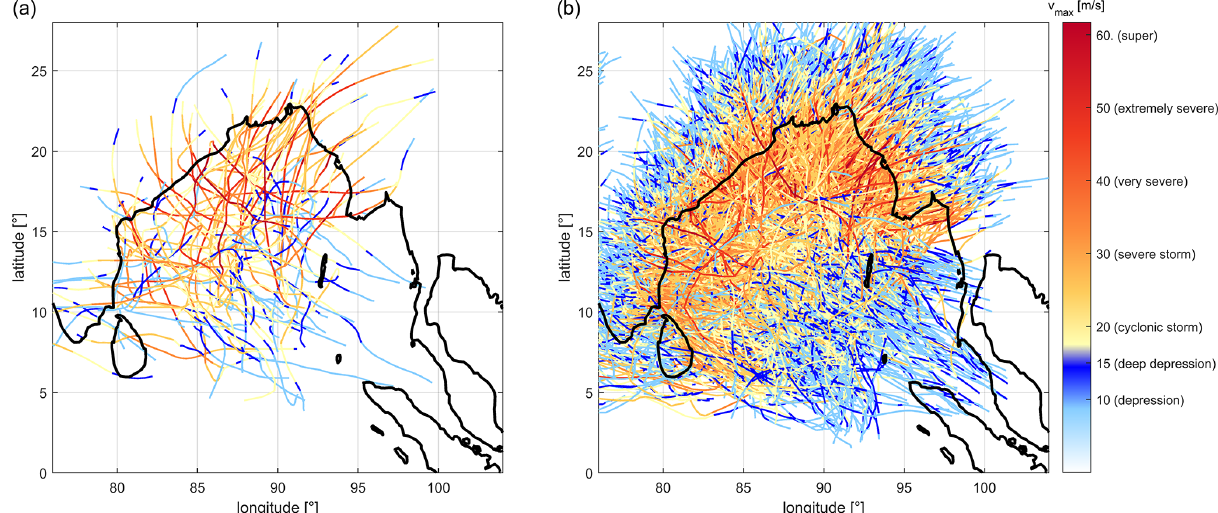
Figure 2. Cyclone tracks subdivided into different cyclone wind speed categories based on the intensity scale of the India Meteorologi- cal Department: (a) historical tropical cyclones (HTCs) for the period 1972–2020; (b) synthetic tropical cyclones (STCs) for a period of 1000 years.